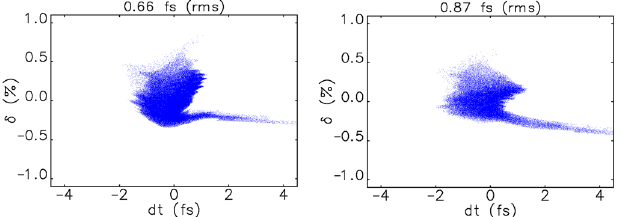
FIG. 9. Final longitudinal phase spaces simulated by IMPACT - T (left) and CSRT rack (right) for the hybrid compression scheme. The final bunch charge is 2.7 pC and the full width of the slit is 0.3 mm. The final normalized horizontal emittances are about 0.19 and 0 . 21 μ m